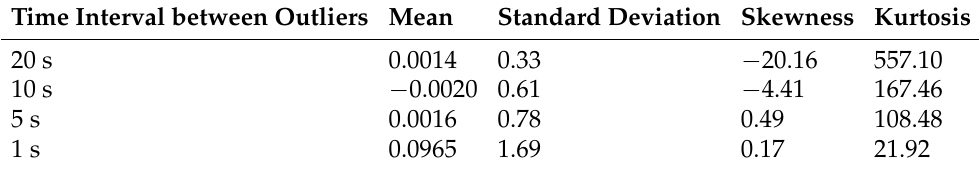
Table 2. Statistical measurements of the rastreaming error of the controlled system using the MCC criterion.